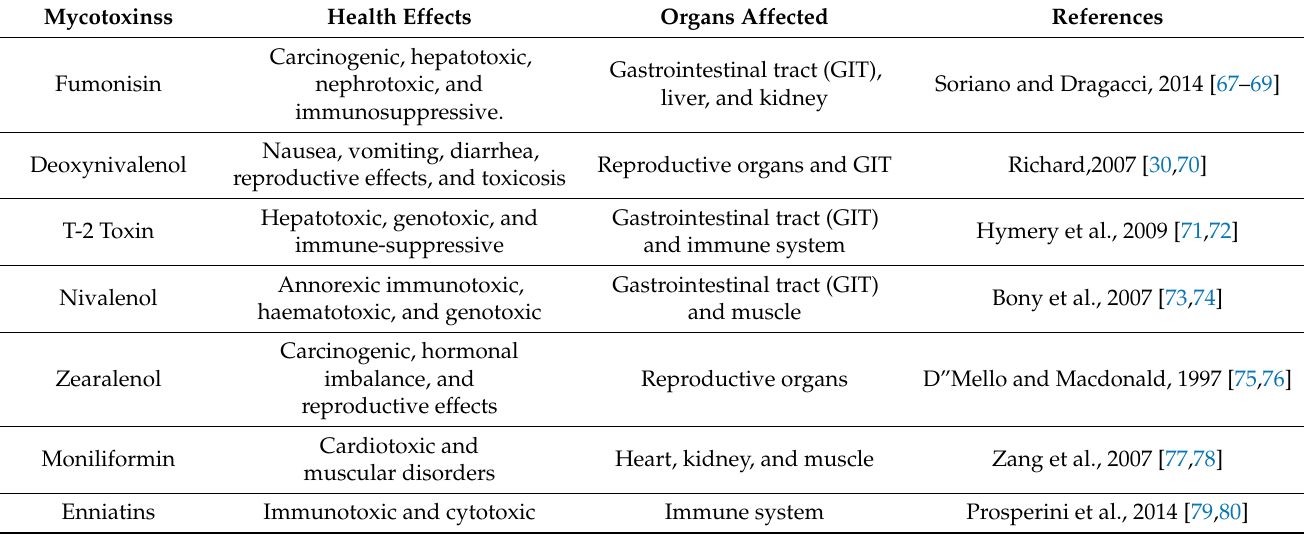
Table 2. Health effects of some Fusarium